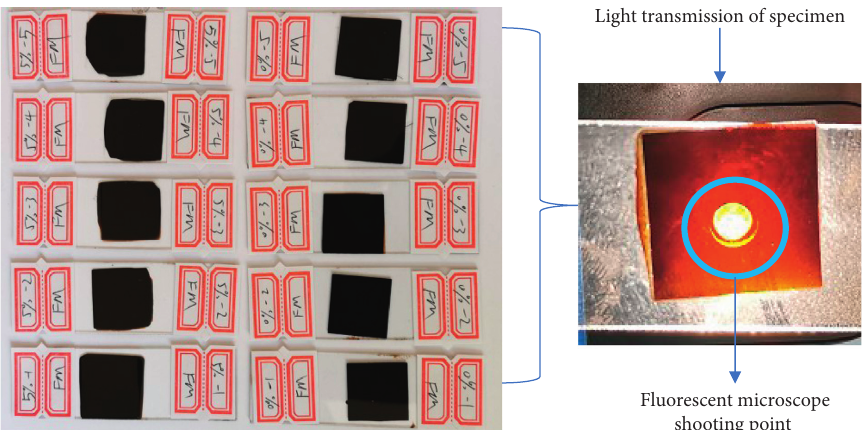
Figure 1: An example of the specimens prepared in this paper and a photo of the fluorescence microscopic test point.